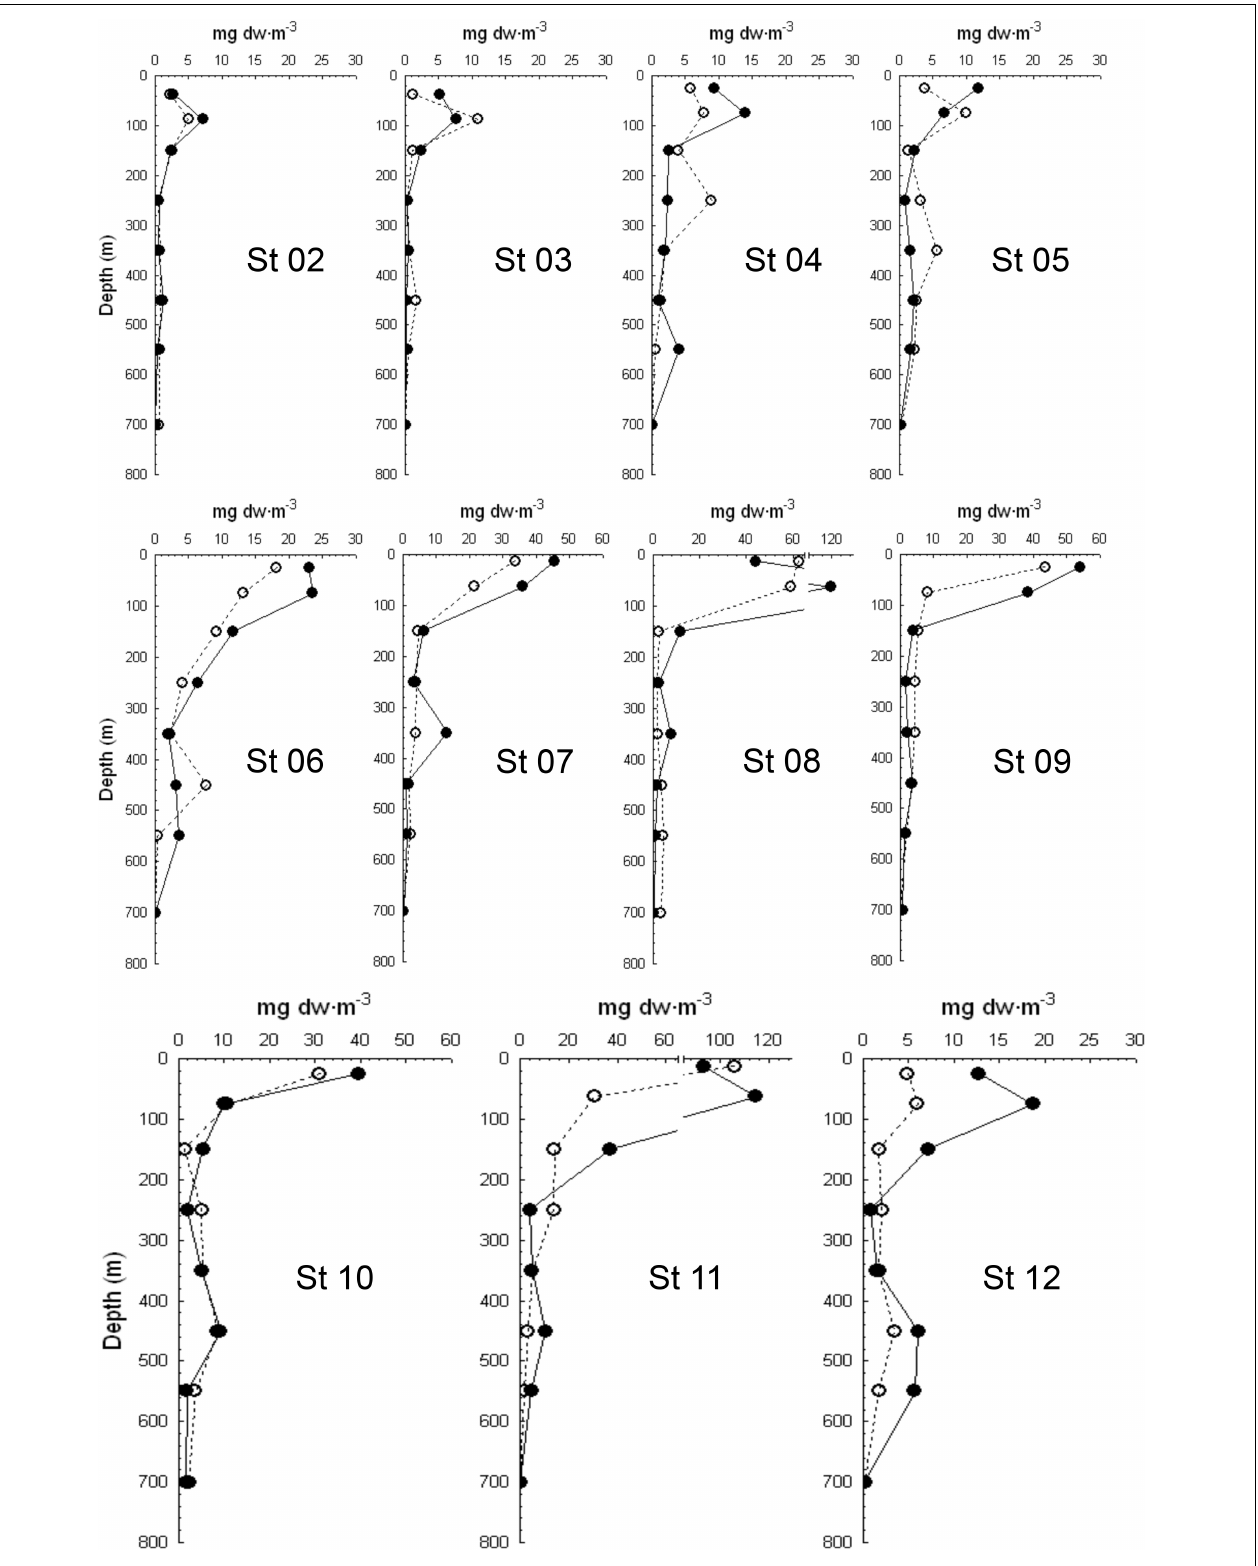
FIGURE 4 | Vertical distribution of zooplankton biomass during day (empty dots) and night (black dots) at the different stations along the Atlantic Ocean transect.